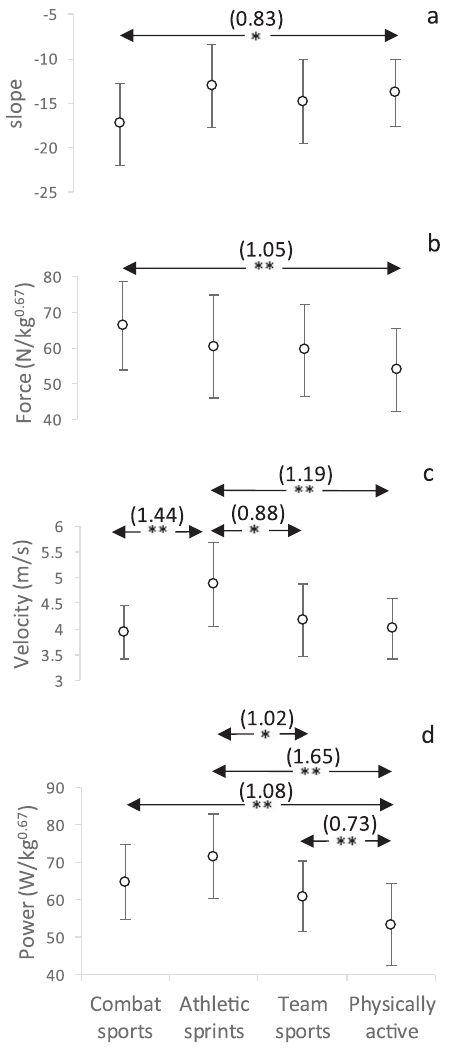
FIGURE 2 Averaged values of the regression parameters, slope (panel a), FMAX (panel b), VMAX (panel c) and PMAX (panel d), for different groups of subjects (mean with SD error bars). The lines with arrows depict differences between groups at p < 0.05 (*) and p < 0.01 (**) with corresponding effect sizes in